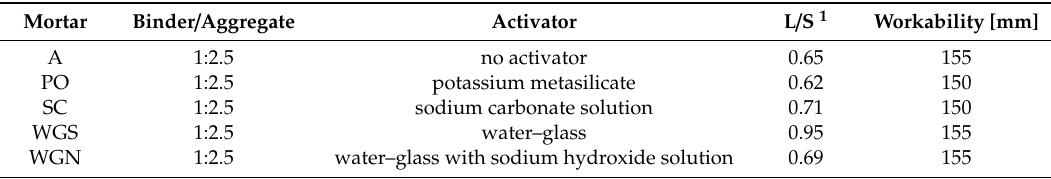
Table 1. Workability of the fresh mortars.